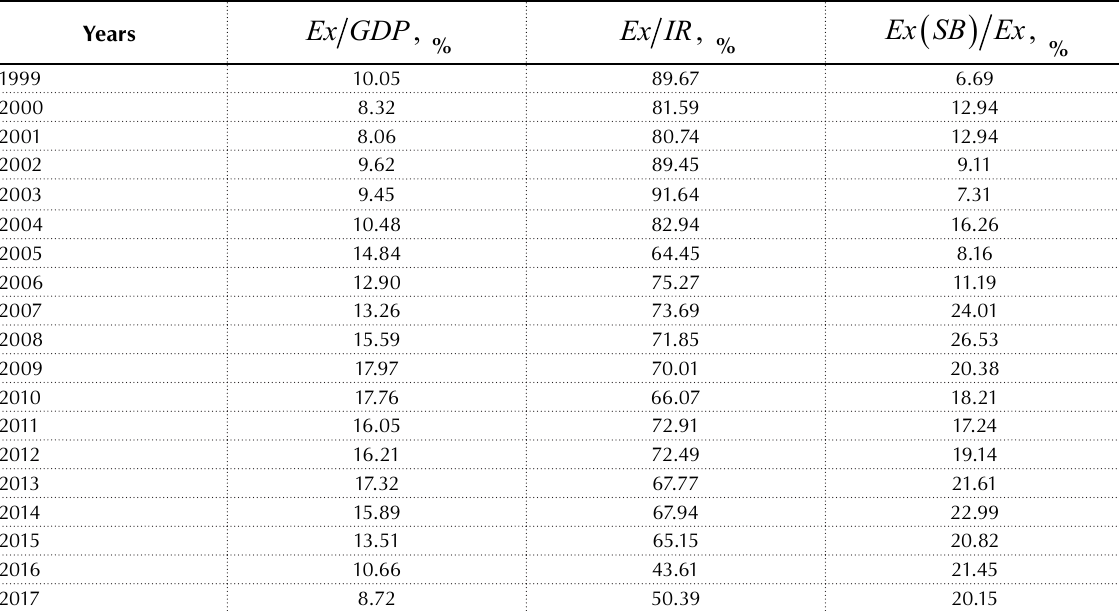
Table 6. Calculation of financial determinants for defining the type of financial sustainability of the Ukrainian pension system for